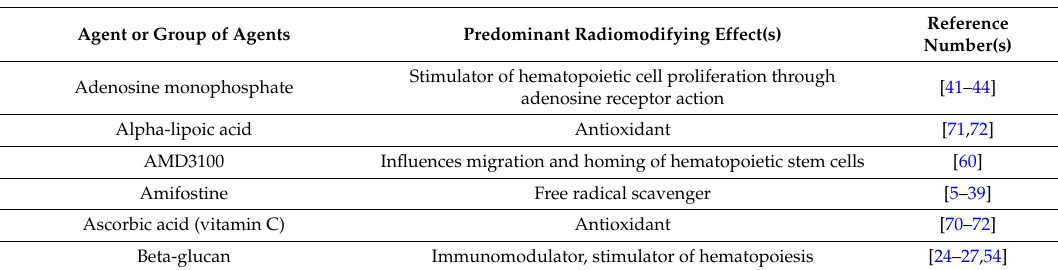
Table 1. Summary of agents tested in pharmacological combinations in attempts to modify the course of the acute radiation syndrome (ARS).